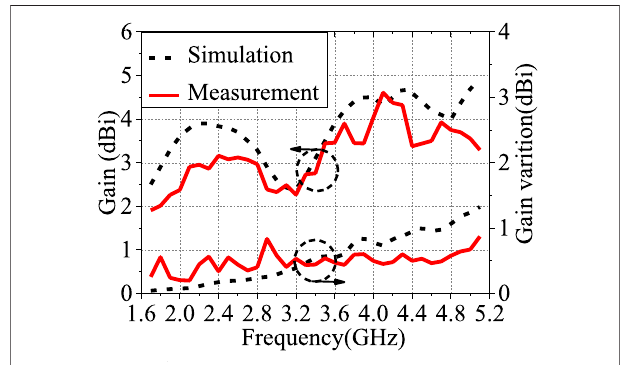
FIGURE10| Measuredgainandgainvariationoftheproposedantenna.